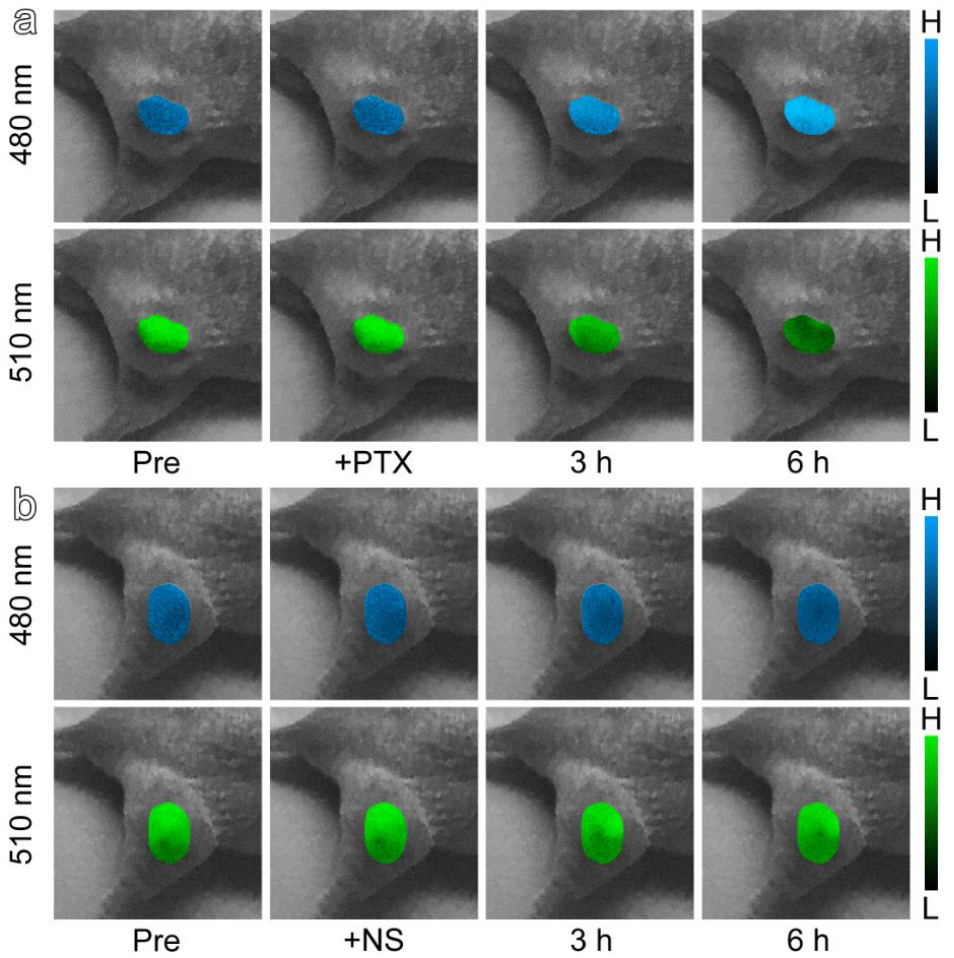
Figure 4. ( a ) Color-coded fluorescence images of TAT-ANNA injected into tumor-bearing mice based on the emission of blue and green channels after having been treated with ( a ) Paclitaxel Injection (PTX) or ( b ) normal saline (NS).